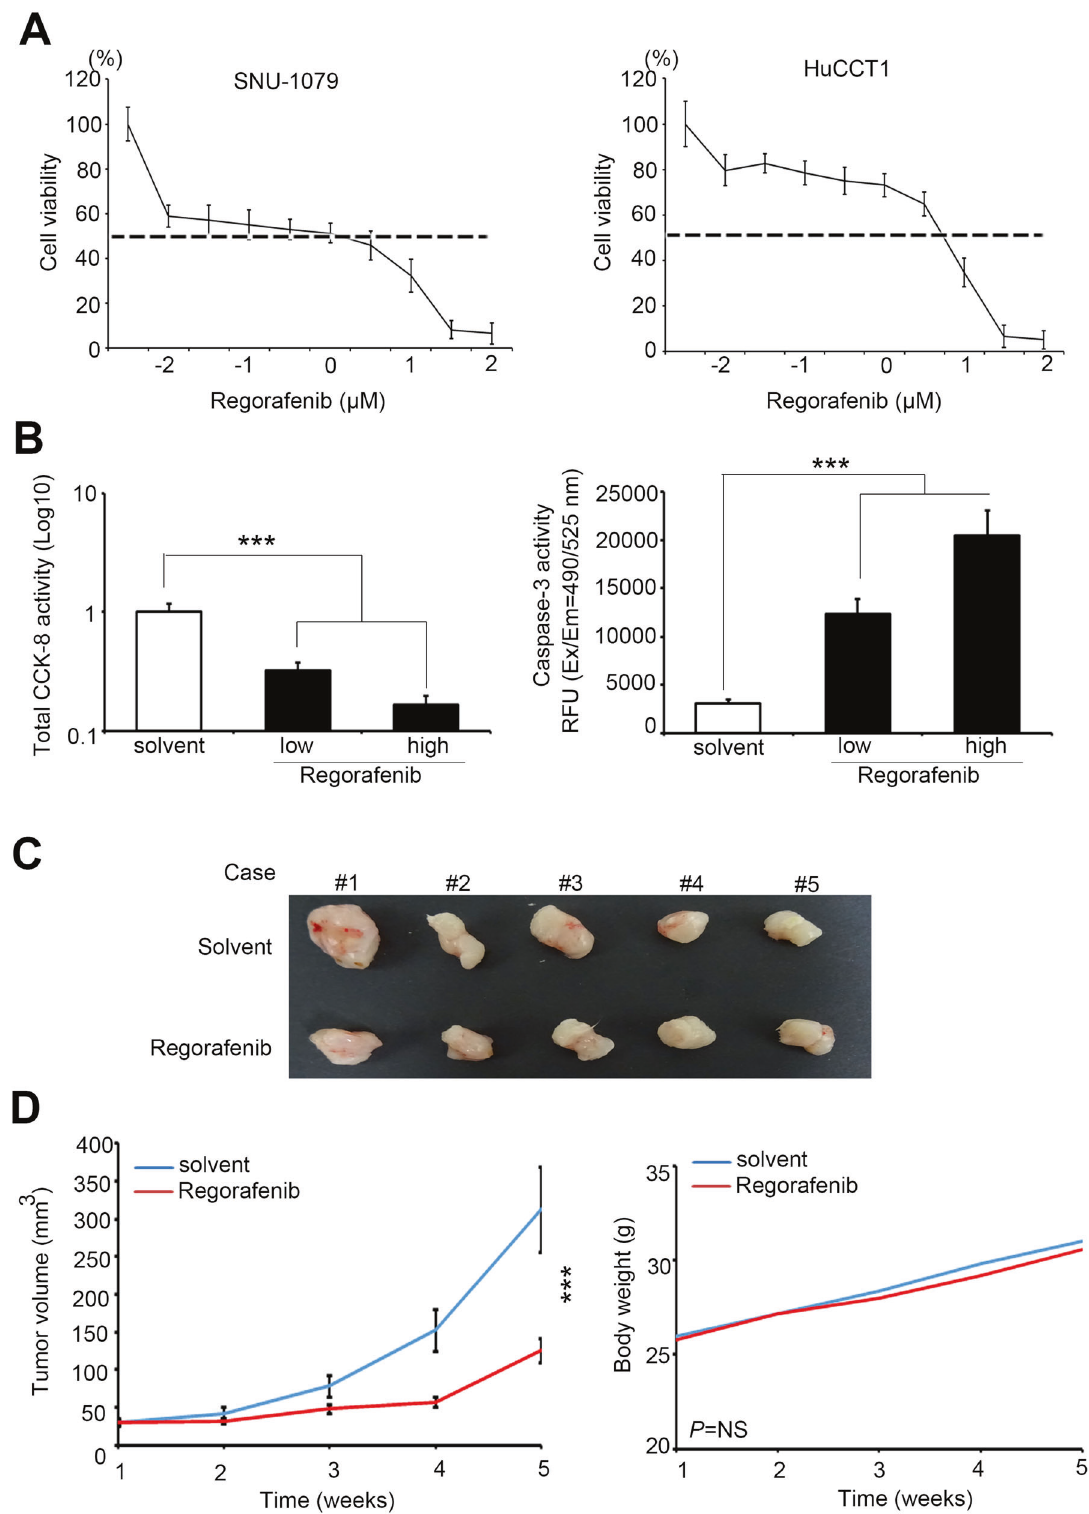
Fig. 3 Regorafenib also interferes cell viability and tumorigenesis of CCA cells. A Viability of SNU-1079 and HuCCT1 cells after regorafenib treatment. B Quantitative CCK-8 activity and Caspase 3 activity with or without regorafenib treatment in CCA cells. C HuCCT1 cells were subcutaneous injected into NOD-SCID mice that were treated over an interval of 2 day with saline only (PBS) and regorafenib. D Quanti fi ed plot of the growth curve and body weight in each group. Data are presented as the mean of three independent experiments ± SEM. The signi fi cance of the difference was determined using a nonparametric Mann – Whitney U -test. * p < 0.05, ** p < 0.01, *** p < 0.001.